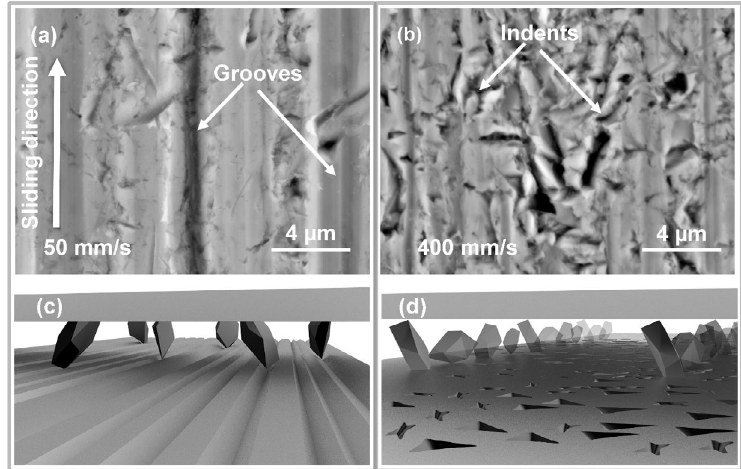
Fig. 8 Two distinct worn surfaces generated by particles in different kinematic states and their schematics: (a) heavily-grooved surface at 50 mm/s by two-body abrasion; (b) scattered indented surface at 400 mm/s by three-body abrasion; (c) schematic of two-body abrasion in the lubricated contact; and (d) schematic of three-body abrasion in the lubricated